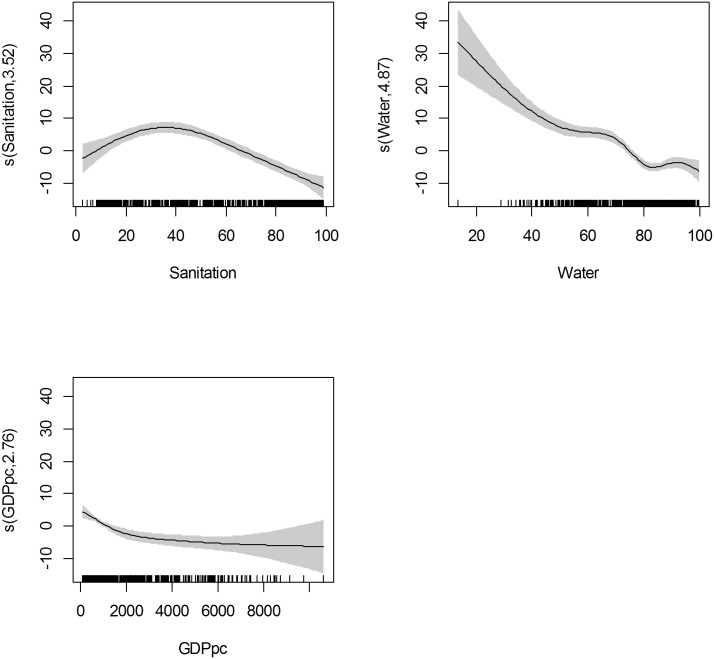
Partial residual plots showing impact on water and sanitation coverage at national level on percent of children under 5 years old with stuntinga,b.aEach y axis shows the partial residual plot of the predictor with the relevant estimated degrees of freedom, with the partial residuals having a mean of zero. A decline of 10 along the y axis would equate to a 10% reduction in the outcome variable assuming the other predictors remained constant. The grey shaded area represents the 95% confidence intervals. The grey shaded area represents the 95% confidence intervals. The small lines on the x axis represent the data points. b stunting is proportion of children under 5 whose height for age is more than two standard deviations below the median for the international reference population ages 0–59 months.